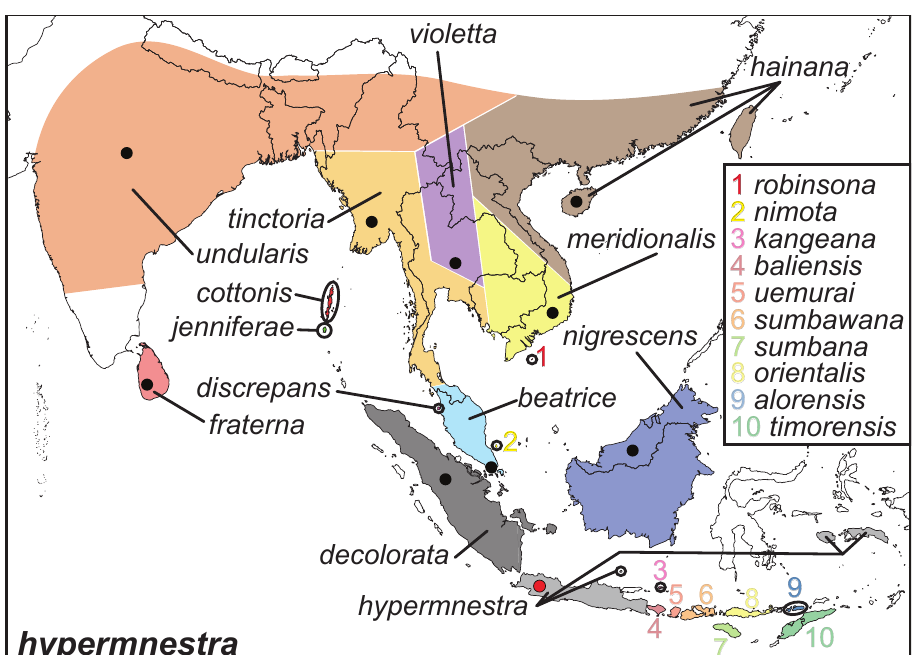
Figure 40. Distribution map of Elymnias hypermnestra